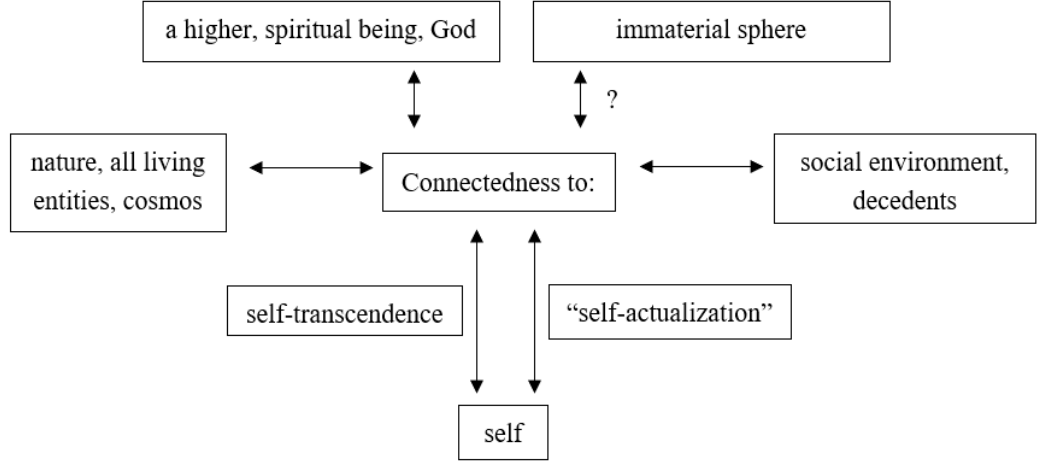
Figure 5. The extended model of spirituality as connectedness by Bucher. Based on Spiritualität (p. 40) by A. Bucher, 2014, Weinheim: Beltz. © by Beltz.